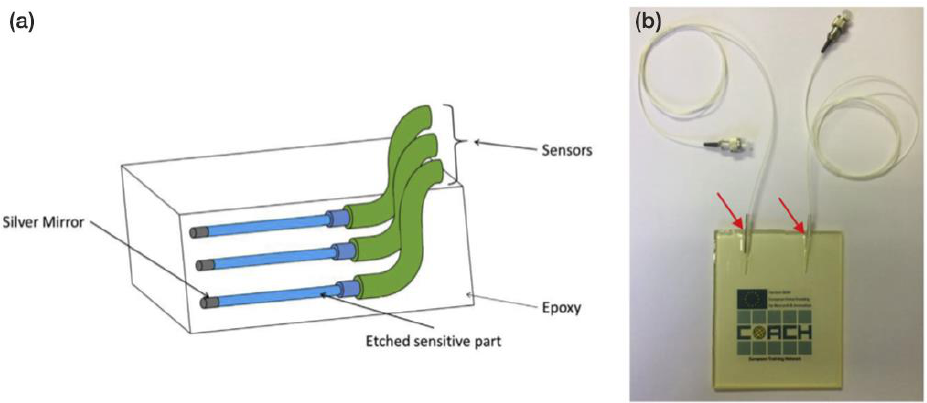
Figure 17. ( a ) A schematic of multiple OFSs embedded at different depths in an epoxy sample. ( b ) A digital image of a sample with two embedded OFSs. Reprinted with permission from ref. [29]. Elsevier, 2018.